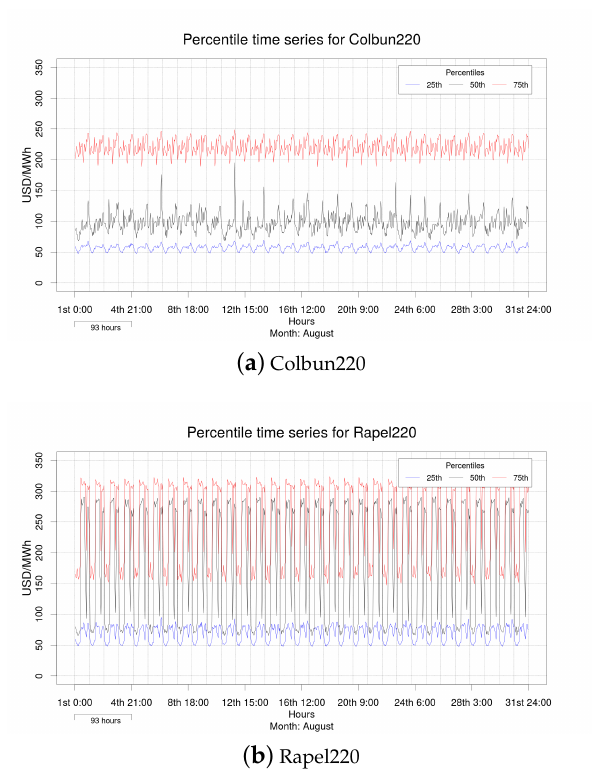
Figure 8. Percentile time series for ( a ) Colbun220 and ( b ) Rapel220 for the month of